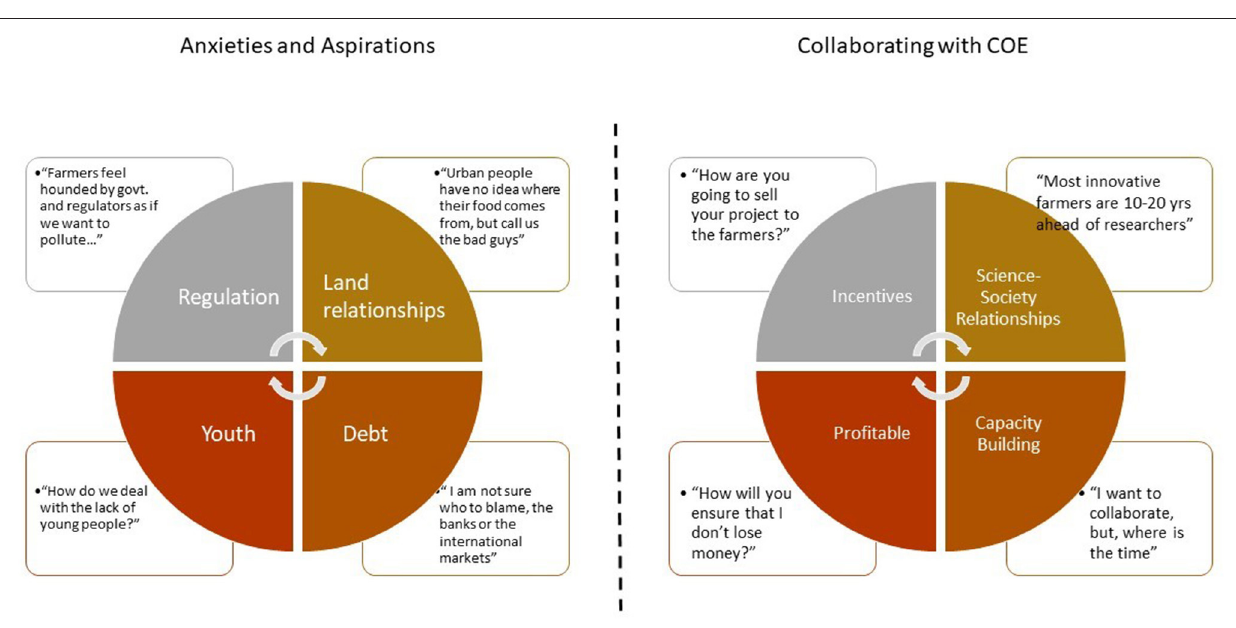
FIGURE 5 | Farmer opinions: emerging themes with representative direct